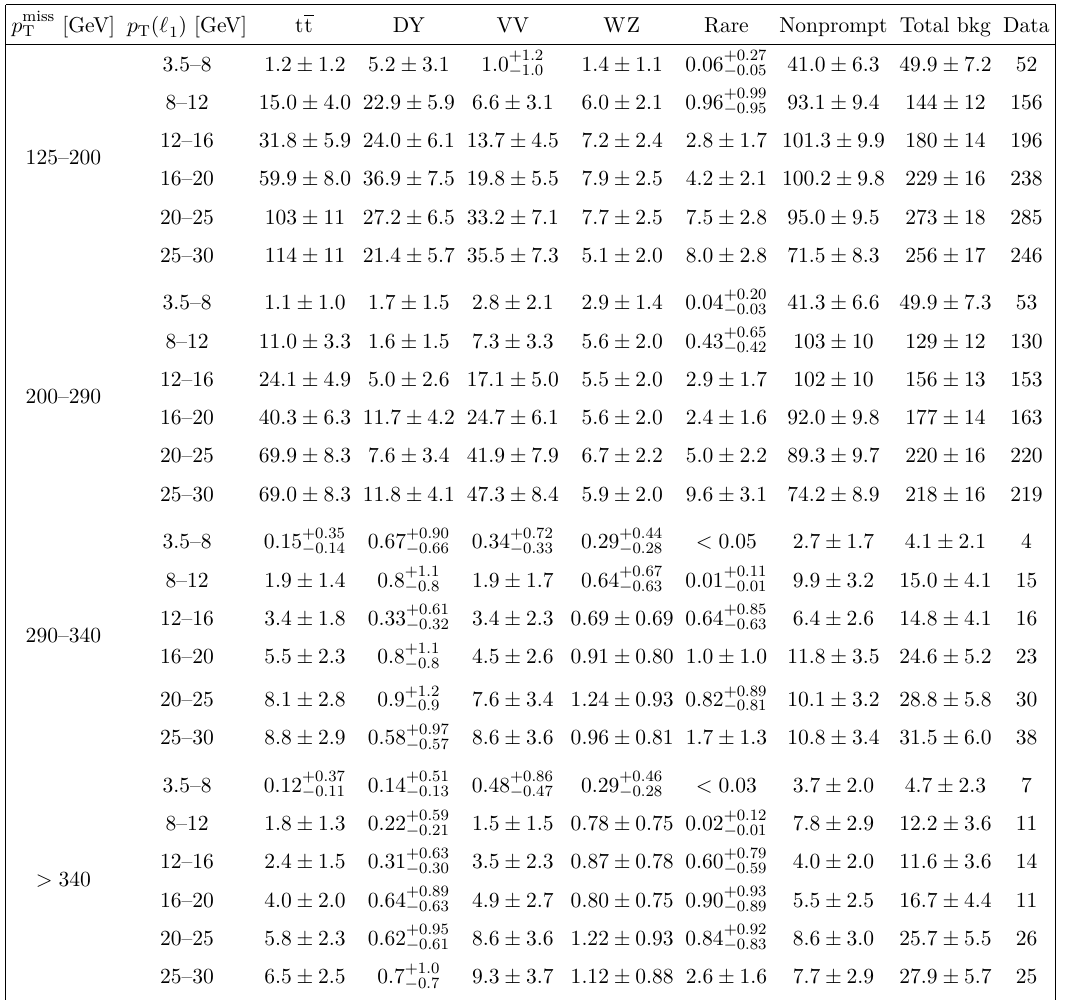
Table 7 . Observed and predicted yields as extracted from the maximum likelihood fit, in the 2 ‘ -Stop SRs. Uncertainties include both the statistical and systematic